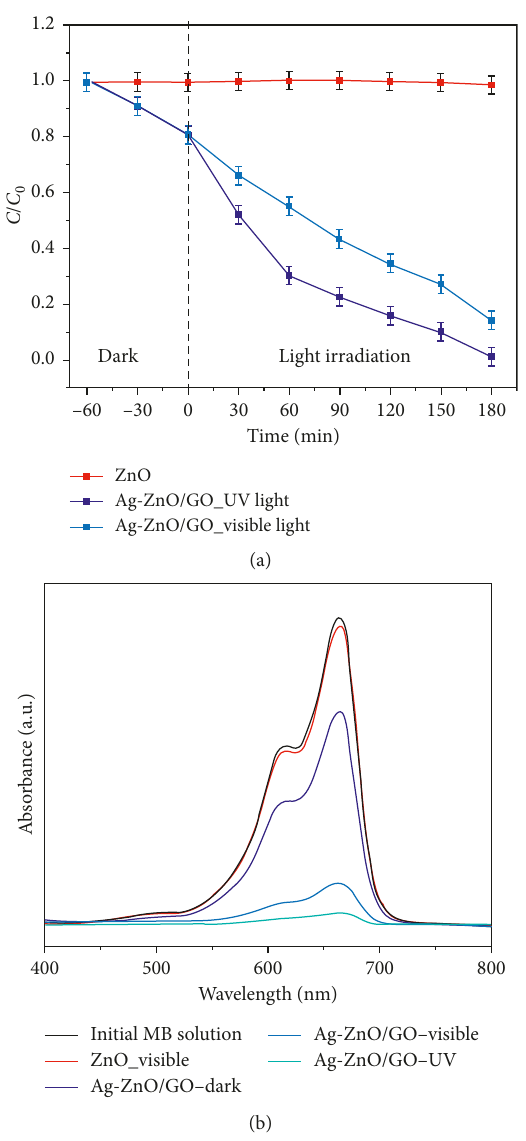
Figure 8: Removal of MB by using synthesized materials.